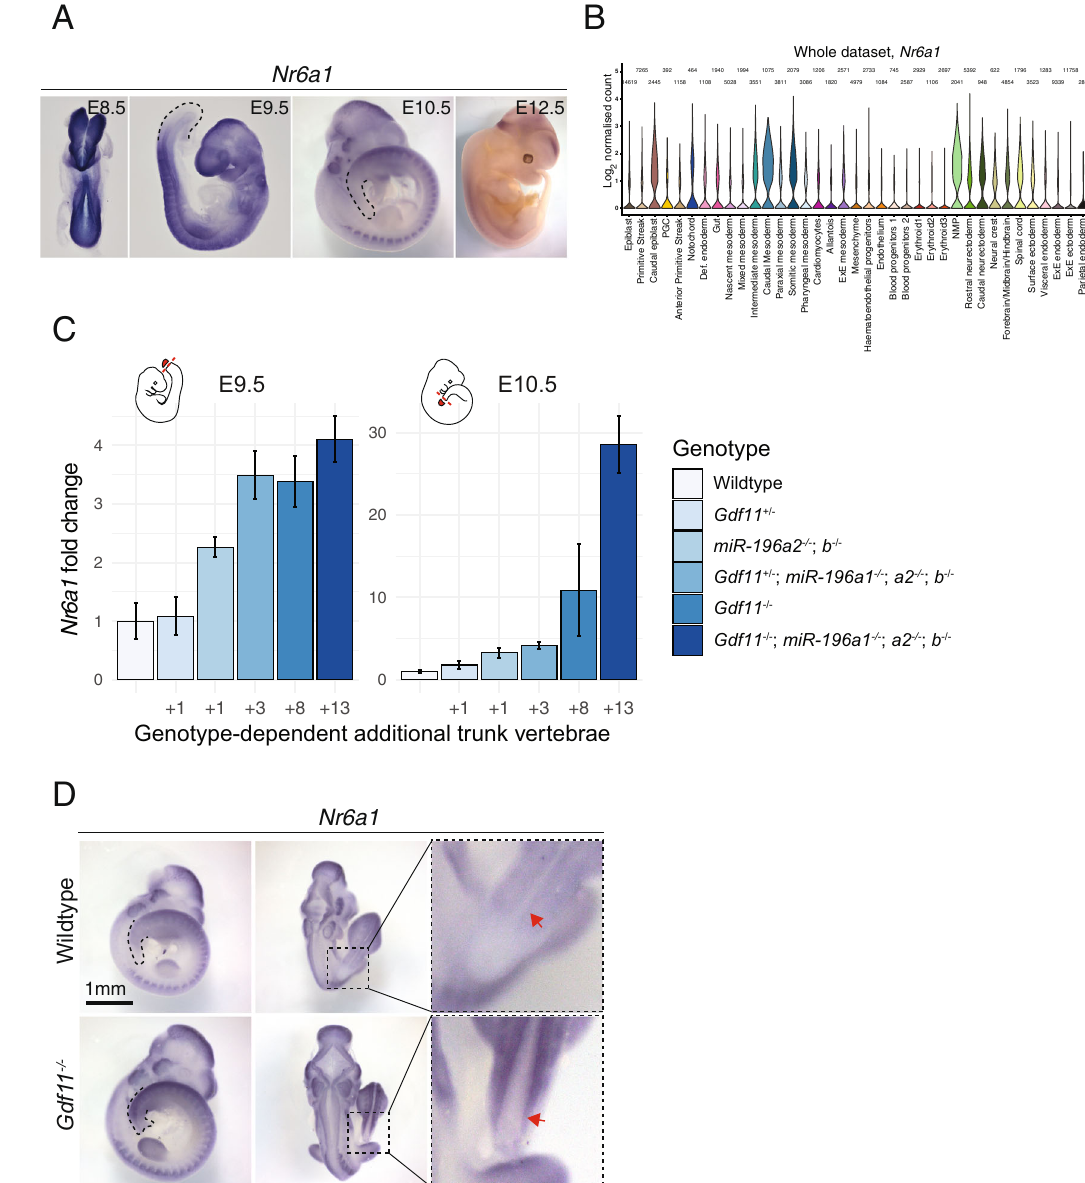
Fig. 1 | Nr6a1 expression level positively correlates with the trunk vertebral number and is regulated by known mediators of the trunk-to-tail transition. A Nr6a1 is expressed broadly at embryonic day (E)8.5, with expression becoming progressively excluded from the posterior growth zone starting E9.5. By E10.5 Nr6a1 exhibitstissue-speci fi cexpression,followedbycompletetissueclearanceby E12.5. B Violin plot illustrates the Log 2 normalised count, which was derived from the raw counts from each cells divided by their sizefactors, of Nr6a1 in cellsofthe E6.5 to E8.5 mouse embryo, revealing robust expression within neuromesodermal progenitors(NMP),caudalmesodermandcaudolateralepiblast.Dataderivedfrom ref.[41]. C Expressionlevelof Nr6a1 withinthetailbudpositivelycorrelateswiththe number of trunk vertebrae that form later in development. Quantitative PCR ana- lysis of Nr6a1 within tailbud tissue isolated from Gdf11 and miR-196 single and